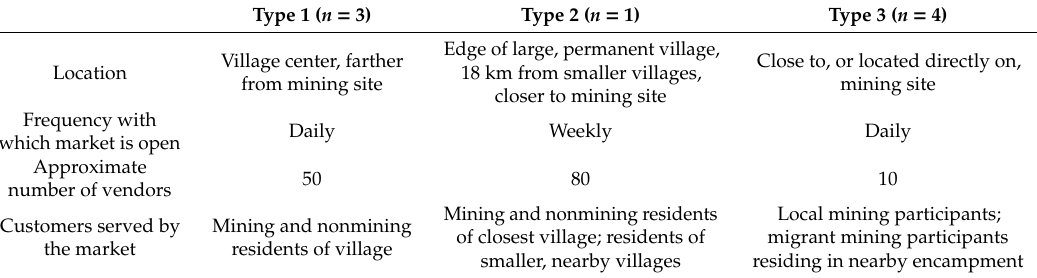
Table 1. Three types of markets serving mining communities in rural Upper Guinea.